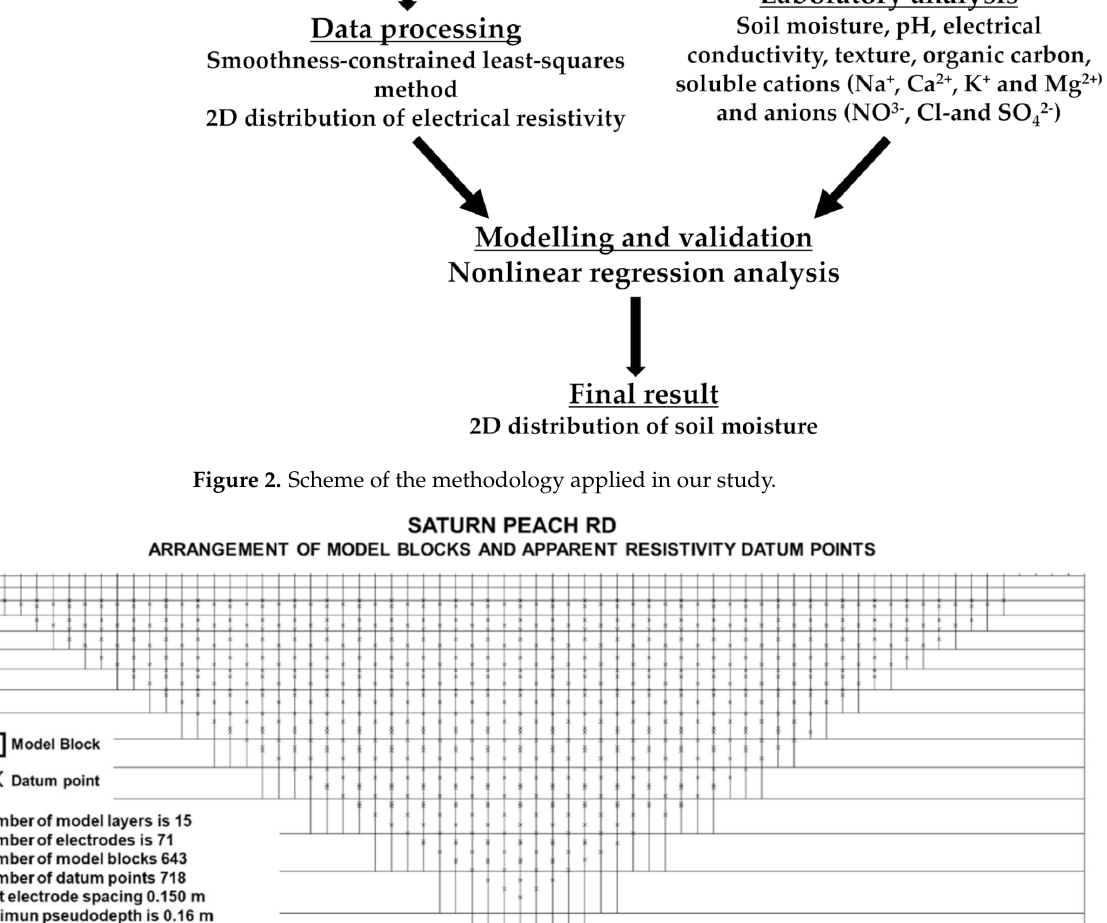
Figure 3. Arrangement of electrodes for a 2D electrical survey and pseudosection data patterns for the Wenner–Schlumberger